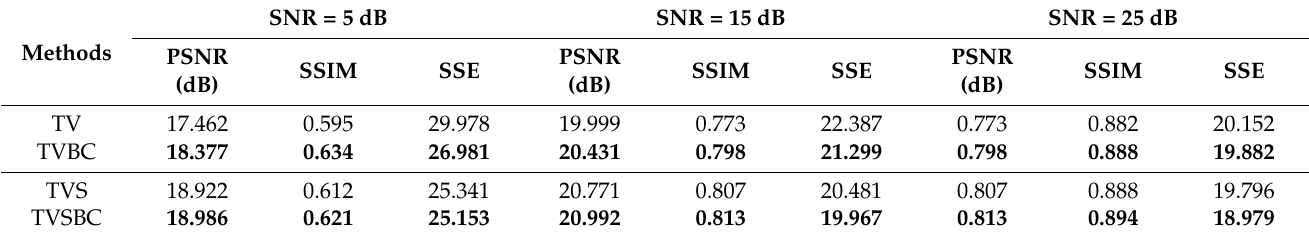
Table 4. PSNR, SSIM, and SSE evaluation results of Figures 11 – 13.